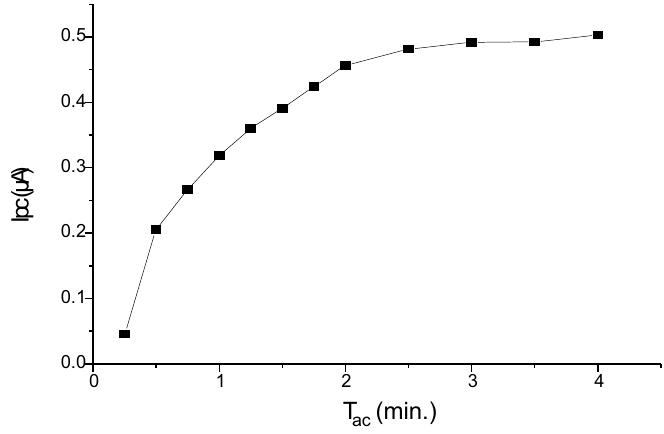
Fig. 4 – Influence of accumulation time on peak current intensity for 1 × 10 − 6 mol L –1 of miconazole in B-R buffer pH 8.0. E ac = 0V and ν = 100 mV s –1 .